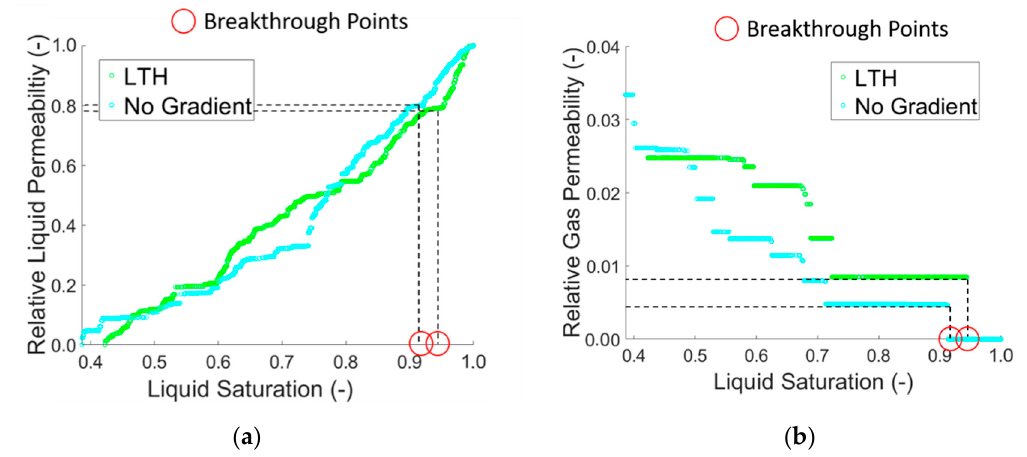
Figure 10. ( a ) Relative liquid permeability and ( b ) relative gas permeability of the 2D pore network simulations from Figure 8.